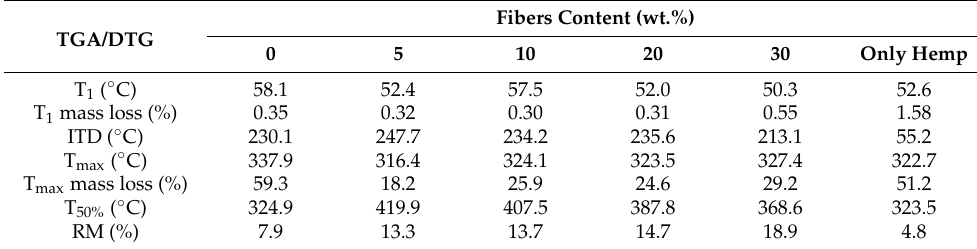
Table 3. TGA and DTG data of the